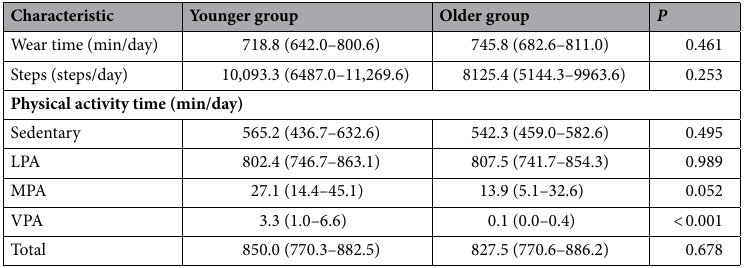
Table 2. Comparison of physical activity between the younger and older groups. Median (25th to 75th percentile), vs. younger group, LPA light-intensity physical activity, MPA moderate-intensity physical activity, VPA vigorous-intensity physical activity.